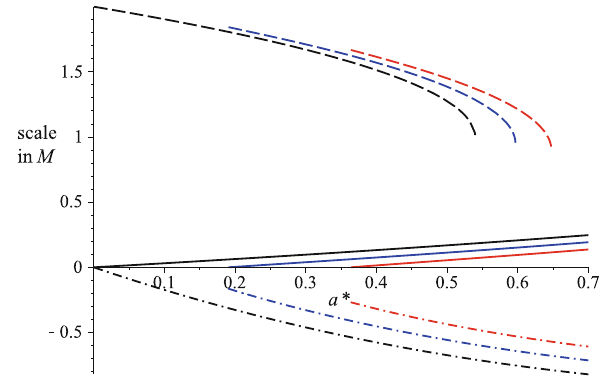
Fig. 1 Plots of circular motion radius (solid) in co-rotating motion, outer horizons (dash), and the corresponding squared NUT parameter l 2 (dash-dot) that solve Eqs. (4.14), (4.15), and (4.16). Plots in black color represent case of b = 0, blue for b = 0 . 05 M , and red for b = 0 . 1 M . We have used a ∗ to denote the ratio a / M . The peculiar behavior of larger radius as a ∗ increases is understood since the events depicted in the plots is not